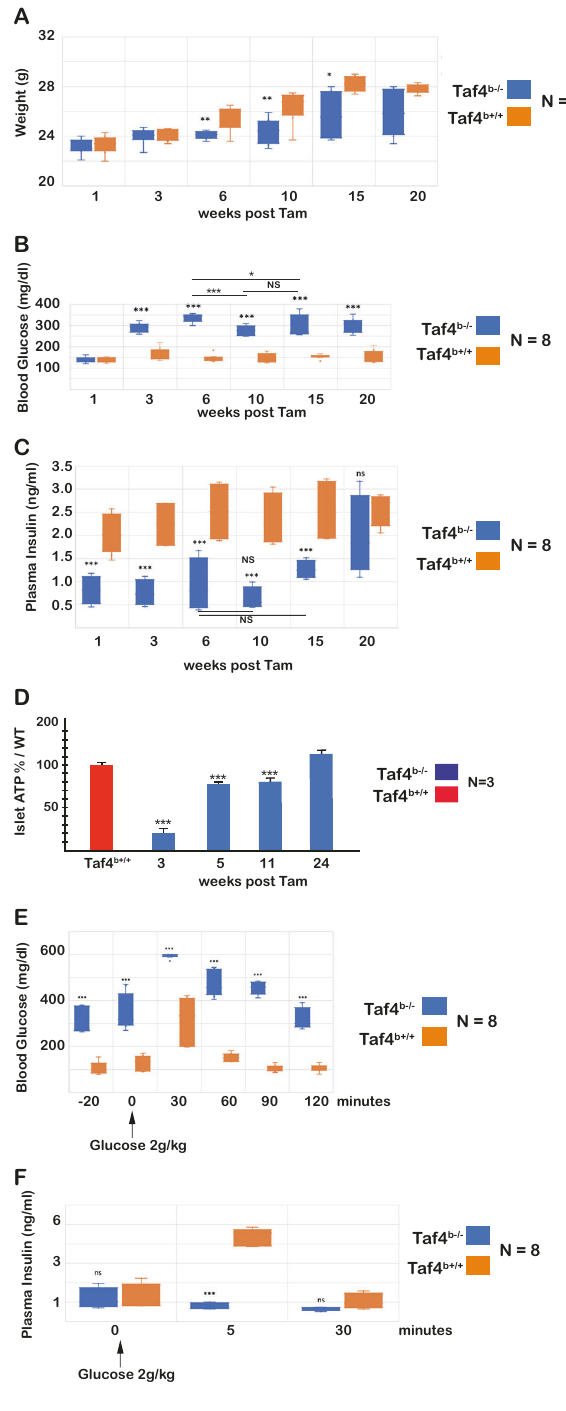
We examined different physiological parameters over 20 weeks following Taf4 inactivation. Compared to Taf4 + / + littermates, Taf4 b − / − animals showed progressive reduction in body weight (Fig. 2A). Fasting blood glucose levels in otherwise ad libitum-fed mice indicated a potent increase in glycaemia after 3 weeks (Fig. 2B) that persisted over 20 weeks, although levels were mildly but signi fi cantly reduced after 10 weeks. Plasma insulin levels were also reduced between weeks 1 – 10, but recovered to those of Taf4 + / + animals at